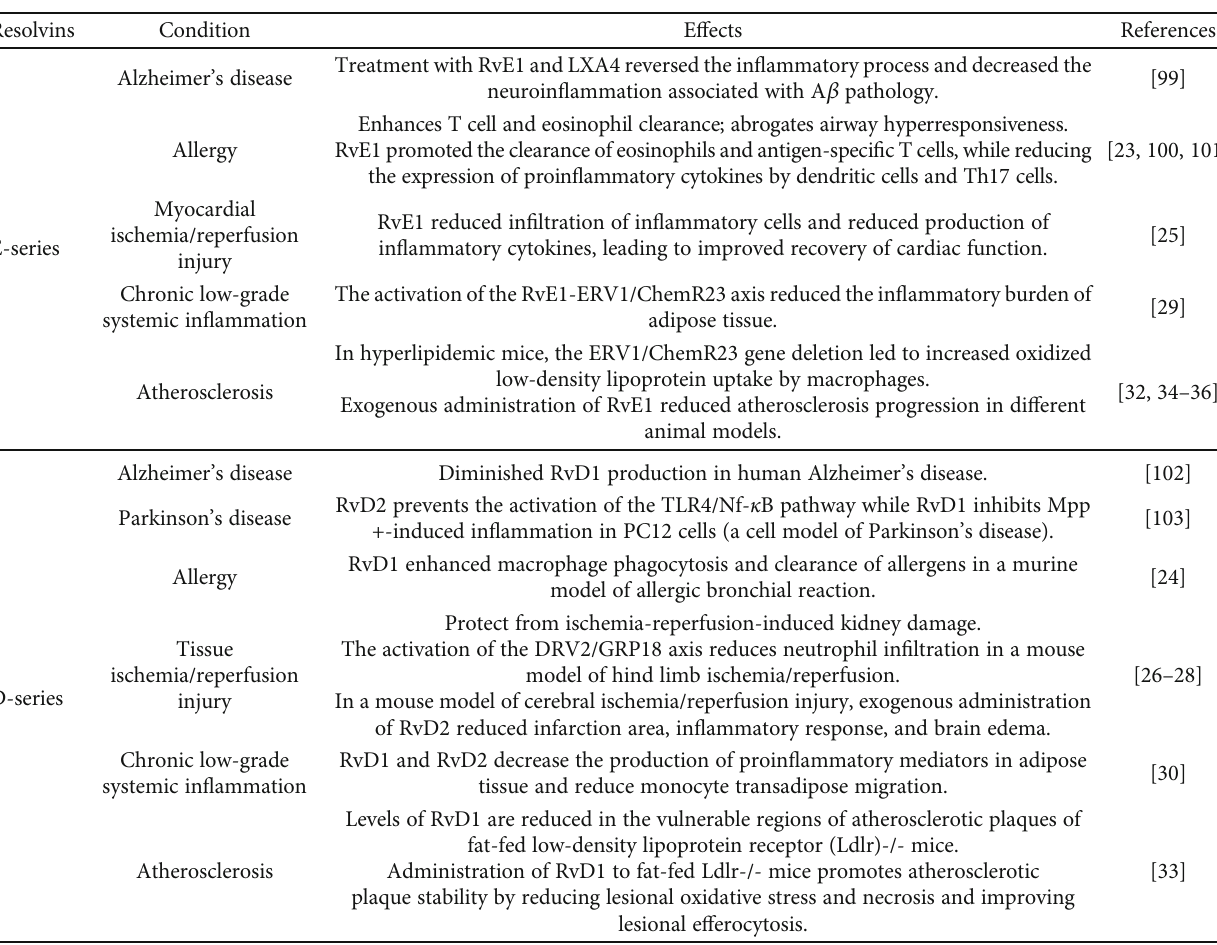
Figure 1: Scheme showing the formation of resolvin. DHA: docosahexaenoic acid; EPA: eicosapentaenoic acid; RvE1: resolvin E1; LOX: lipoxygenases. Table 1: Studies reporting resolvin protective